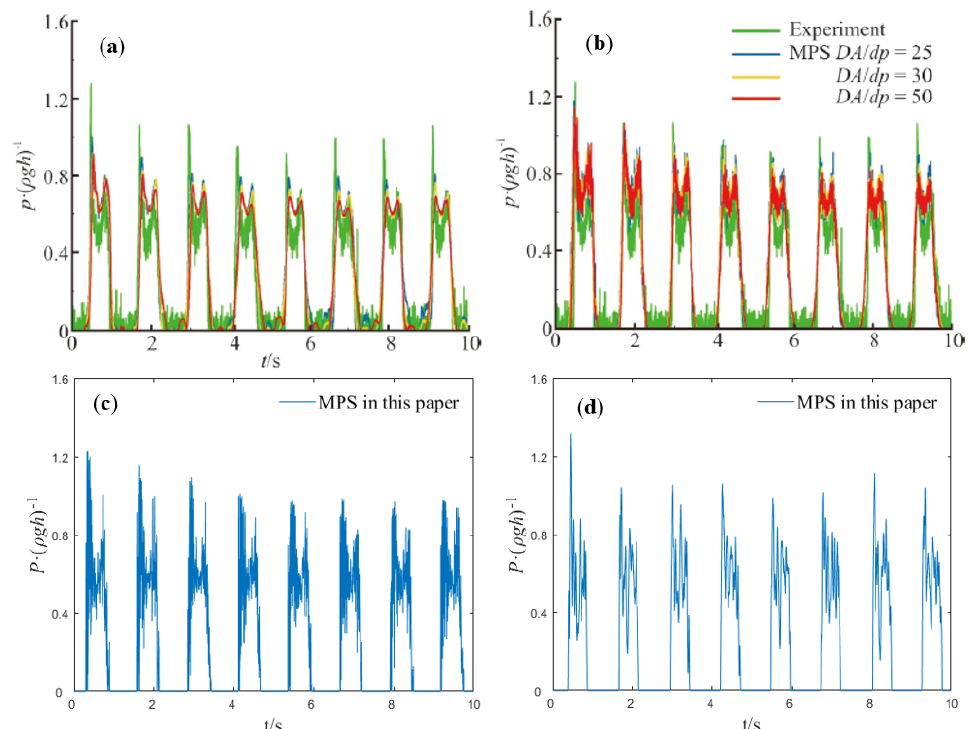
Figure 4. Comparisons of numerical simulation results of the pressure impact at the probe P 0 . ( a ) 2D results given by [52,60]; ( b ) 3D results given by [52,60]; ( c ) 2D numerical simulation results of this paper; ( d ) 3D numerical simulation results of this paper.